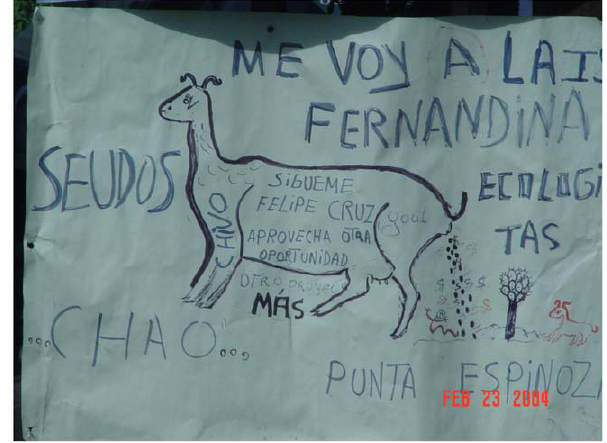
Figure 3. The use of the threat of goat reintroduction to islands in the Gala´pagos as a political tool. A sign during a 2004 local protest at the Gala´pagos National Park headquarters, where local fishermen were demonstrating for additional fishing permits. The sign threatens to introduce goats to Fernandina Island, which is the only large island in the archipelago that does not have a history of introduced herbivores.